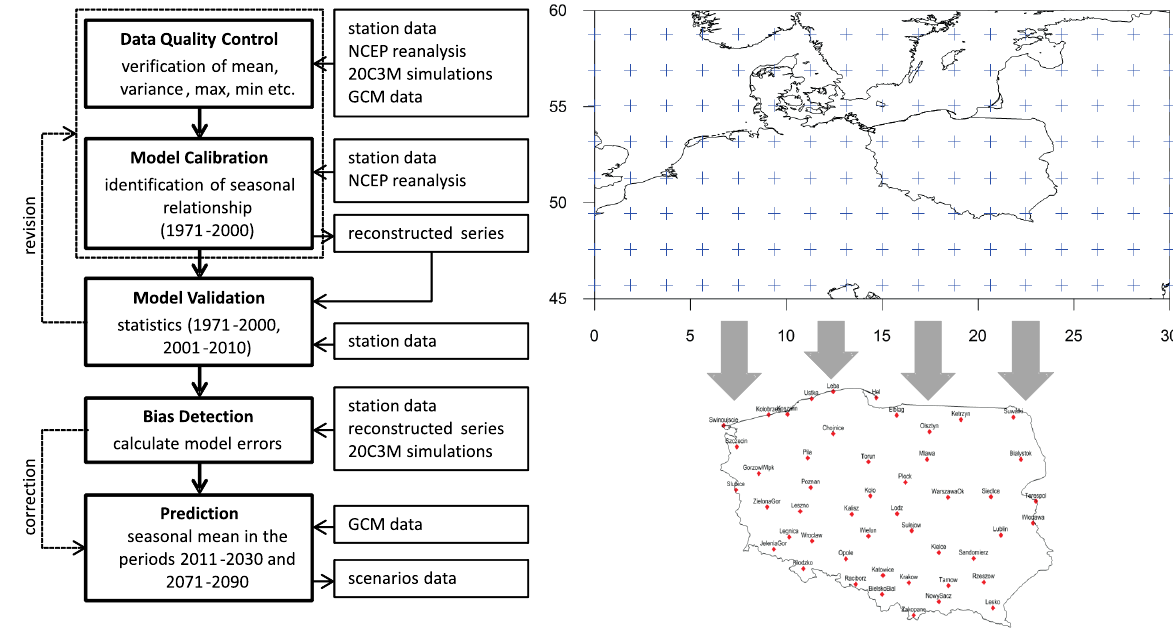
Fig. 2. Main stages in CCA method. Left panel contains bolded boxes which represent main steps of the method. Data Quality Control was performed to verify basic statistics, histograms, outliers etc. Model Calibration phase identify connections between predictor and predictand. Model Validation check reliability of the model (with revision – back step if not reliable). Bias Detection based on reconstruction and original data was calculated to correct scenarios in XXI century. The final step Prediction concerns estimating seasonal means for two periods in XXI century. Horizontal vectors represent input/output data from/to right-side boxes. Right panel shows predictors spatial large-scale domain with grid horizontal resolu- tion (blue crosses) and predictand small-scale field represented by measurement stations (red